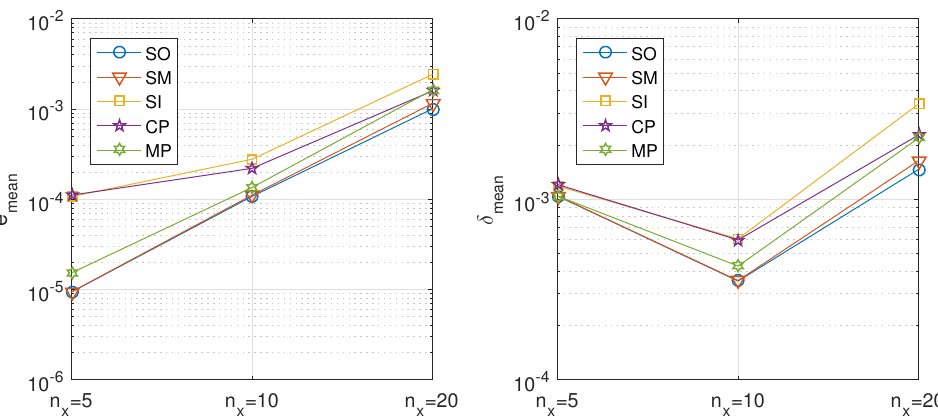
Figure 10. Mixed convection-diffusion and Burgers’ equation, directional decomposition. Precision of the proposed methods: sequential iterative SI, classical parallel CP, and modern parallel MP, compared with the classical ones: sequential operator SO and Strang–Marchuk SM, for different number of spatial steps in the directional decomposition.